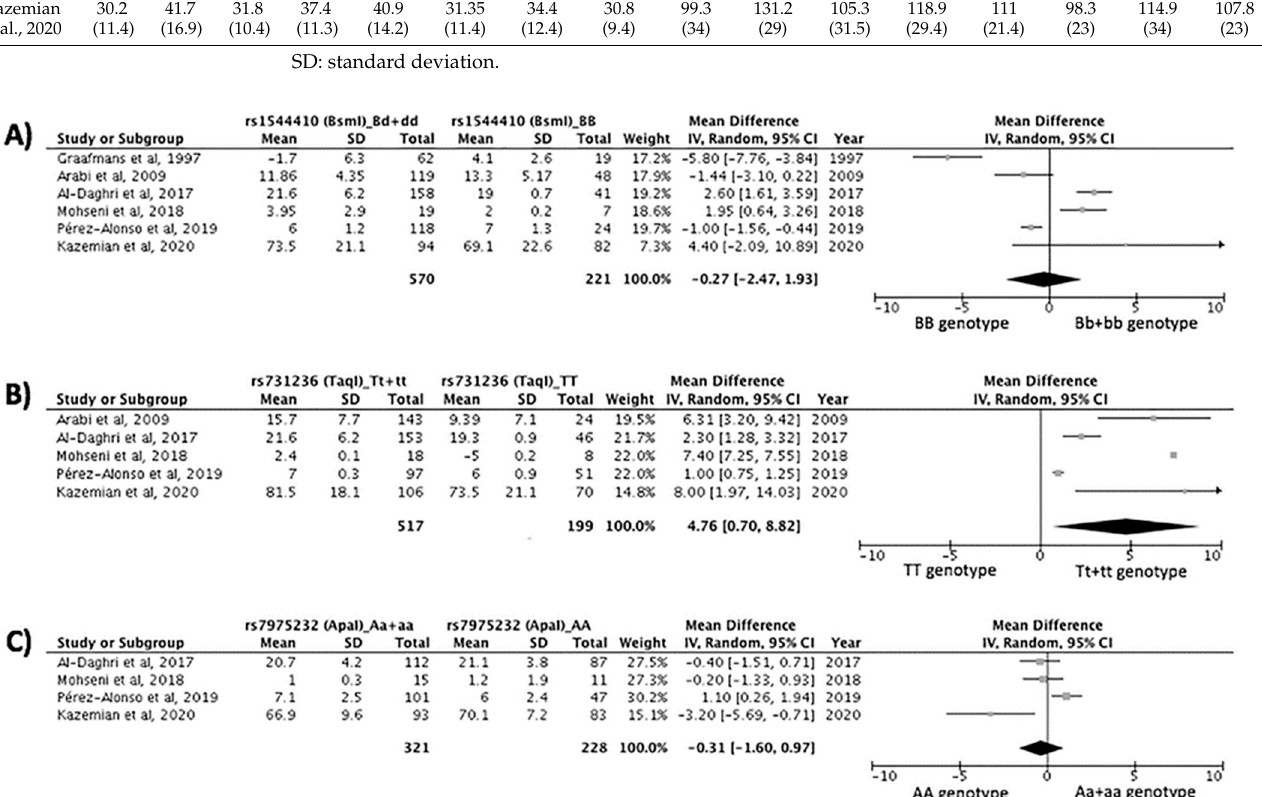
Figure 2. Meta-analysis of the association between gene variants in the vitamin D receptor ( VDR) gene and the response to vitamin D supplementation. ( A ) Association between the BsmI polymor- phism and the response to vitamin D supplementation. Test for overall effect: Z = 0.24 ( p = 0.81). Test for heterogeneity: χ 2 = 6.31 ( p < 0.001), I2 = 9.4%. ( B ) Association between the TaqI polymor- phism and the response to vitamin D supplementation. Test for overall effect: Z = 2.30 ( p = 0.02). Test for heterogeneity: χ 2 = 19.47 ( p < 0.001), I2 = 10%. ( C ) Association between the ApaI polymor- phism and the response to vitamin D supplementation. Test for overall effect: Z = 0.48 ( p = 0.63). Test for heterogeneity: χ 2 = 1.24 ( p = 0.004), I2 = 7.7%. ( D ) Association between the FokI polymor- phism and the response to vitamin D supplementation. Test for overall effect: Z = 9.39 ( p < 0.001). Test for heterogeneity: χ 2 = 2.47 ( p = 0.04), I2 = 5.9%. 4. Discussion The relationship between genetic variants in the VDR gene and the response to vita- min D supplementation remains unclear. Thus, we carried out a systematic review and meta-analysis to evaluate the response to supplementation according to the genotype dis- tribution of the BsmI, TaqI, ApaI and FokI polymorphisms in the VDR gene. The results showed that the variant allele of the TaqI polymorphism and the FF genotype of the FokI variant were associated with a better response to vitamin D supplementation. The BsmI and ApaI polymorphisms were not associated with the response to vitamin D supplemen- tation. Calcitriol signalling is crucial in bone metabolism as it is involved in calcium absorp- tion, parathormone secretion and, therefore, bone resorption and cellular differentiation. Vitamin D deficiency has been associated with bone metabolism alterations [35–37]. Therefore, vitamin D intake as a preventive nutritional treatment of osteoporosis plays an